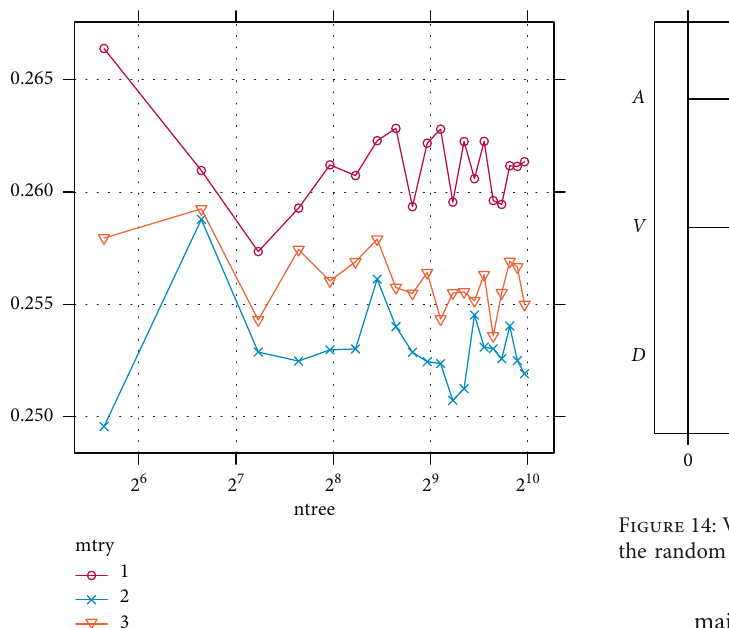
Figure 12: Fivefold cross-validated RMSE profiles for determining the optimal tuning parameters for random forest models.